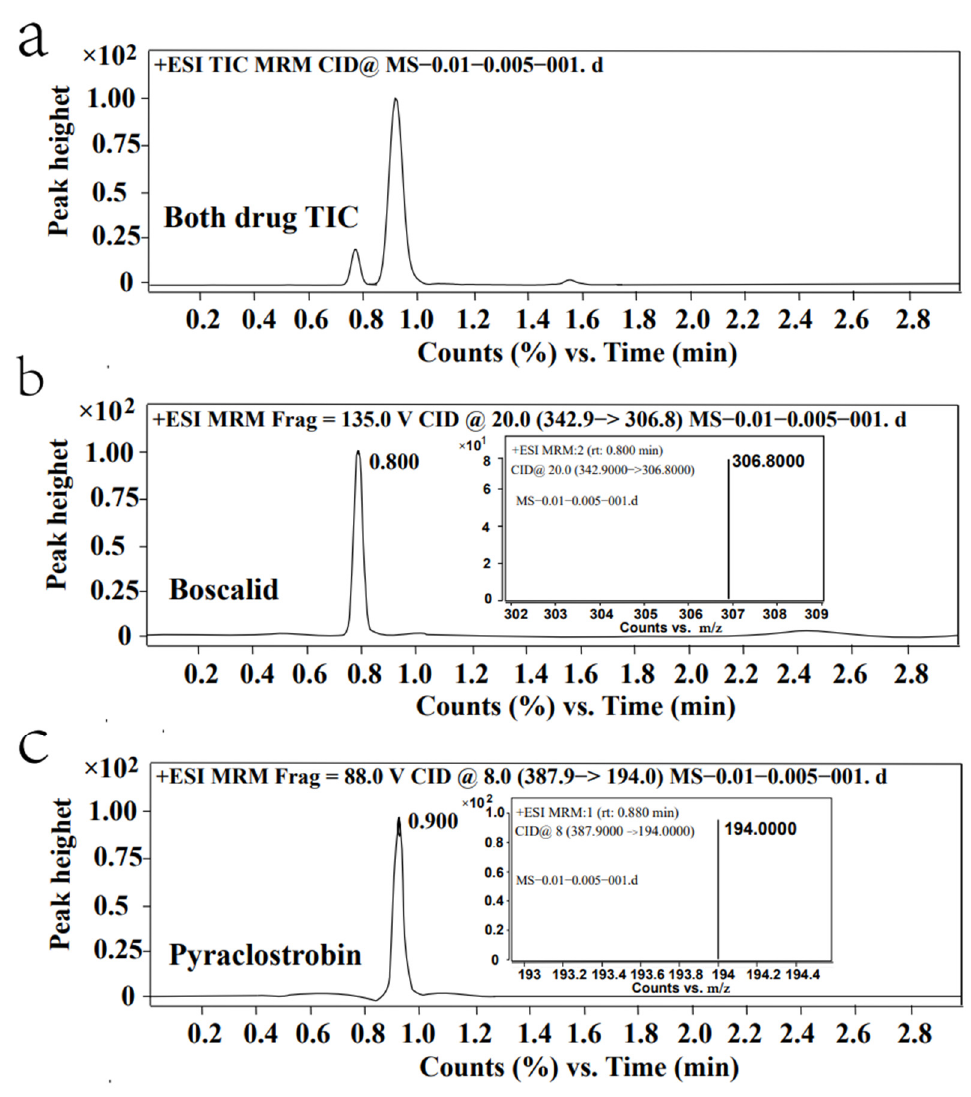
Figure 2. Chromatograms and mass spectra of boscalid and pyraclostrobin; ( a ) show the retention time of boscalid and pyraclostrobin for simultaneous detection; ( b , c ) show the chromatographic peaks and quantitative ions of boscalid and pyraclostrobin in MRM mode, respectively.